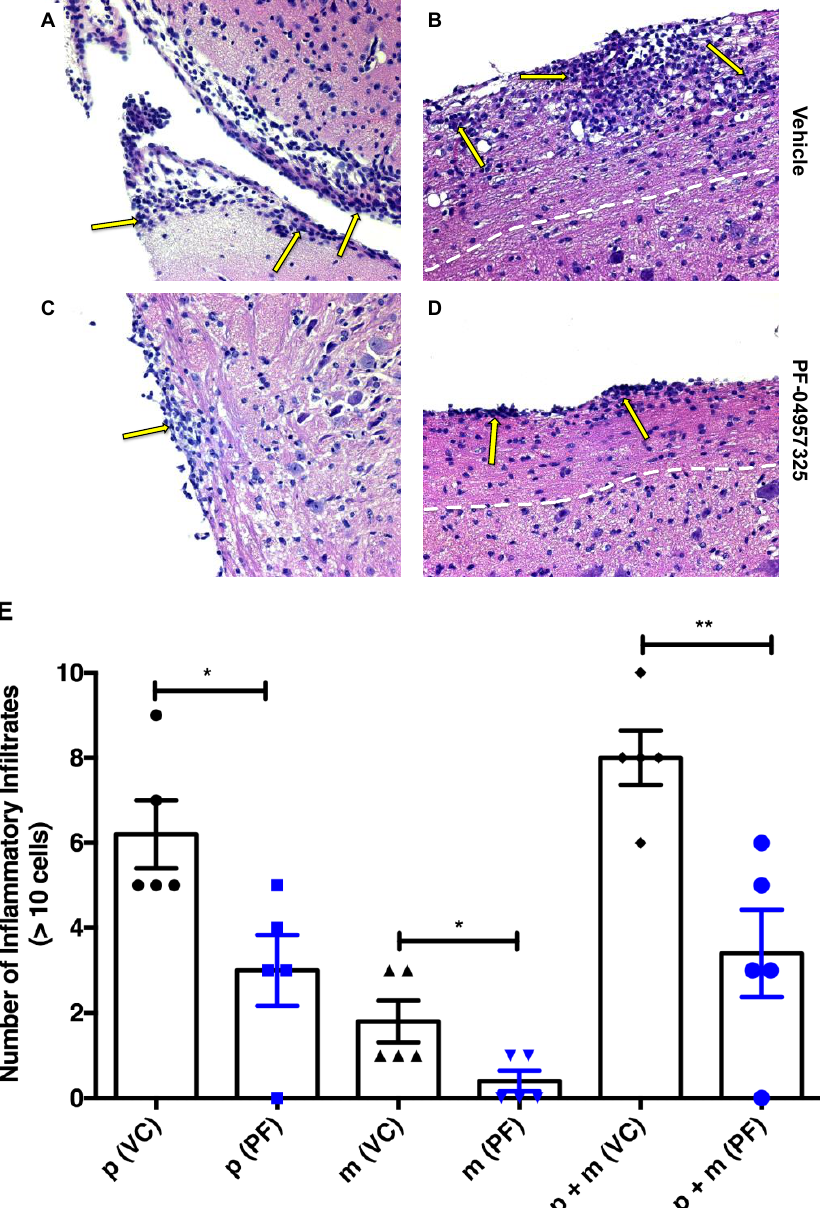
Figure 2. Treatment with PF-04957325 suppresses histopathologic signs of EAE in the CNS. Mice with an EAE score of at least 1 were treated with a vehicle control in an equivalent volume of DMSO and PBS to the corresponding inhibitor dose or PF-04957325 from day 10 to day 13 (twice daily for 4 days), followed by the dissection of their brains and spinal cords for histopathological analysis. The sections were stained with HE, and their inflammatory foci were quantitated according to the published protocols [35,45]. Images of the brain ( A , C ) and spinal cord ( B , D ) sections of the vehicle control (grade 4) and PF-04957325 (grade 2)-treated mice are shown (original magnification 20X). The arrows point to inflammatory foci, and the white lines indicate the border between white and grey matter in the spinal cord. ( E ) The graph represents the number of inflammatory foci containing >10 cells [35,45] present in the spinal cord parenchyma (p) (* p = 0.025), brain meninges (m) (* p = 0.034), and spinal cord parenchyma plus brain meninges (p + m) (** p = 0.005), as assessed in HE sections of the vehicle control (V)- and PF-04957325 (PF)-treated mice. ( n = five mice per